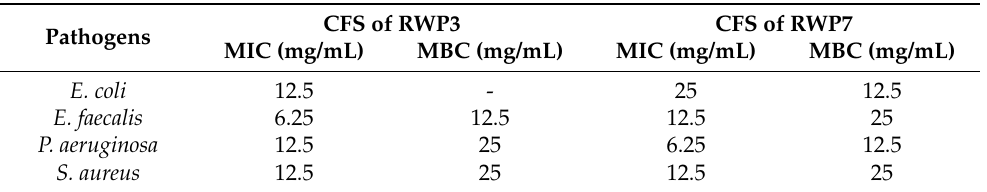
Figure 2. ( A ) Assay of pathogenic bacterial growth inhibition in response to CFS of RWP3 treatment by time and dose-dependent killing method. ( B ) Assay of pathogenic bacterial growth inhibition in response to CFS of RWP7 treatment by time and dose-dependent killing method. ( a ) E. coli vs. CFS, ( b ) E. faecalis vs. CFS, ( c ) P. aeruginosa vs. CFS, ( d ) S. aureus vs. CFS. Data were represented as mean ± SEM of three replicates ( n = 3, p < 0.05). Table 2. Minimum Inhibitory concentration and Minimum bactericidal Concentration (MIC/MBC) of CFS of RWP-3 and